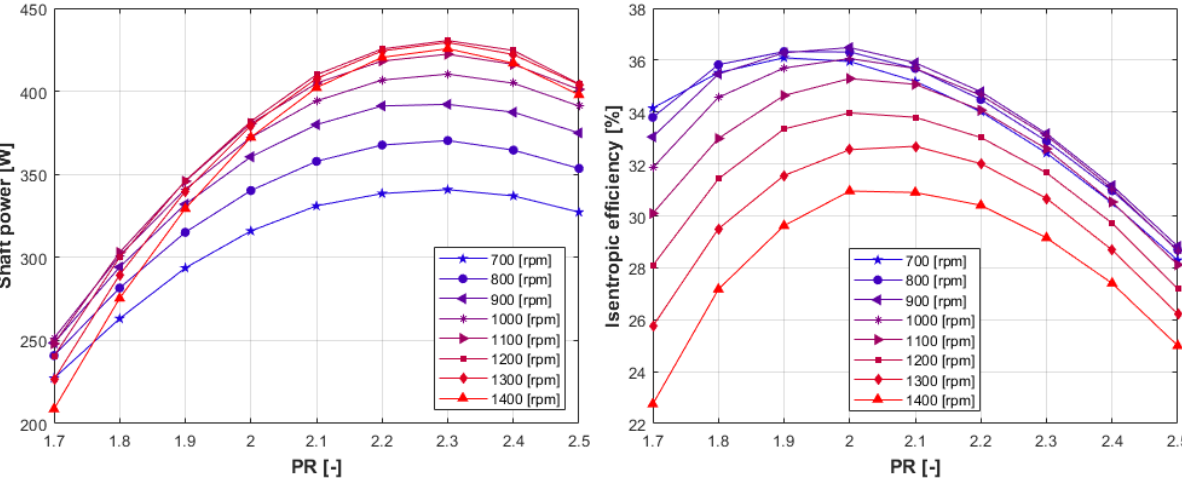
Figure 21. Expander shaft power ( left ) and isentropic efficiency ( right ) with expander pressure ratio (PR) and shaft speed ◦ C, P ◦ C). (T su,exp = 65°C, P su,exp = 15 bar, T amb = 15°C). (T su,exp = 65 su,exp = 15 bar, T amb = 15